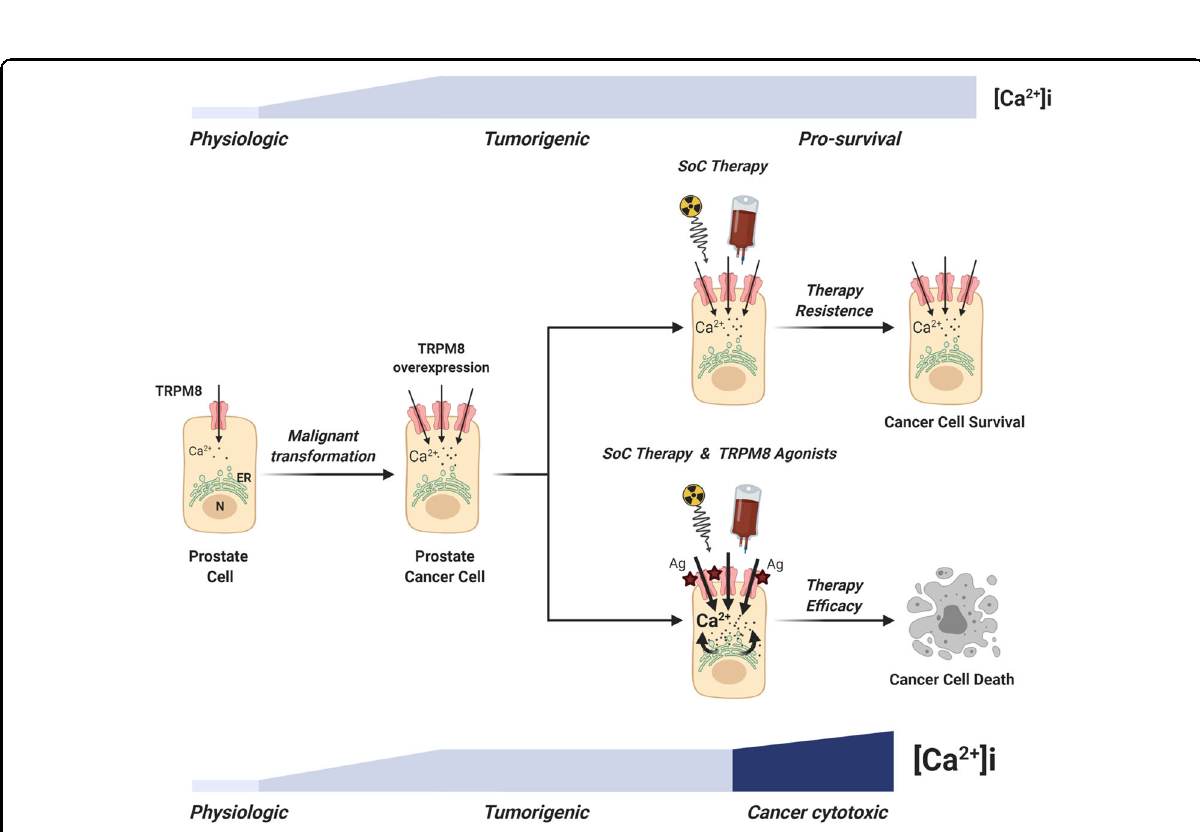
Fig. 7 Proposed model for therapy resistance bypass in PCa cells. The scheme shows the lethal synergy between standard-of-care therapies and Ca 2 + cytotoxicity induced by potent TRPM8 agonists in PCa cells expressing increased amounts of the channel